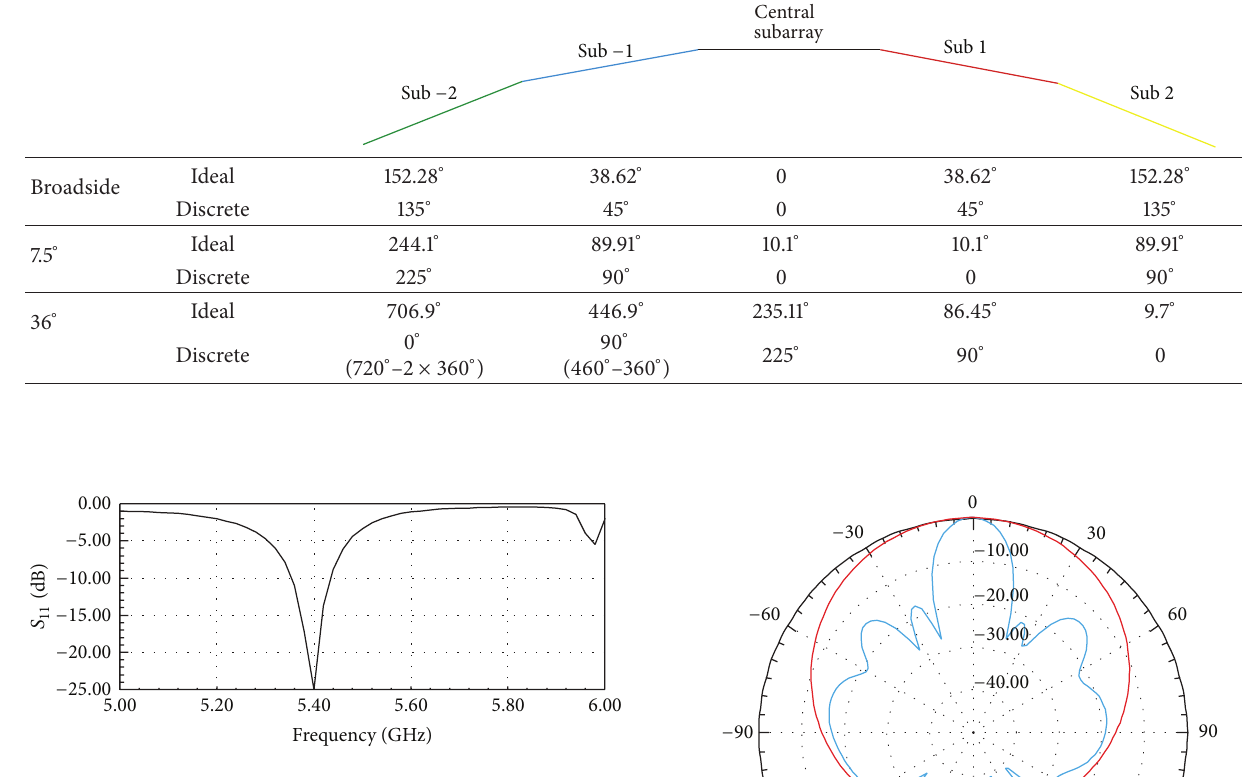
Figure 7: Simulated S 11 at the subarray coaxial feed port.